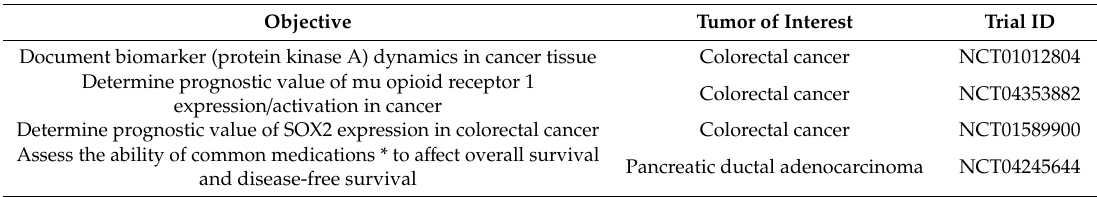
Table 1. Active observational clinical trials examining neuron–tumor